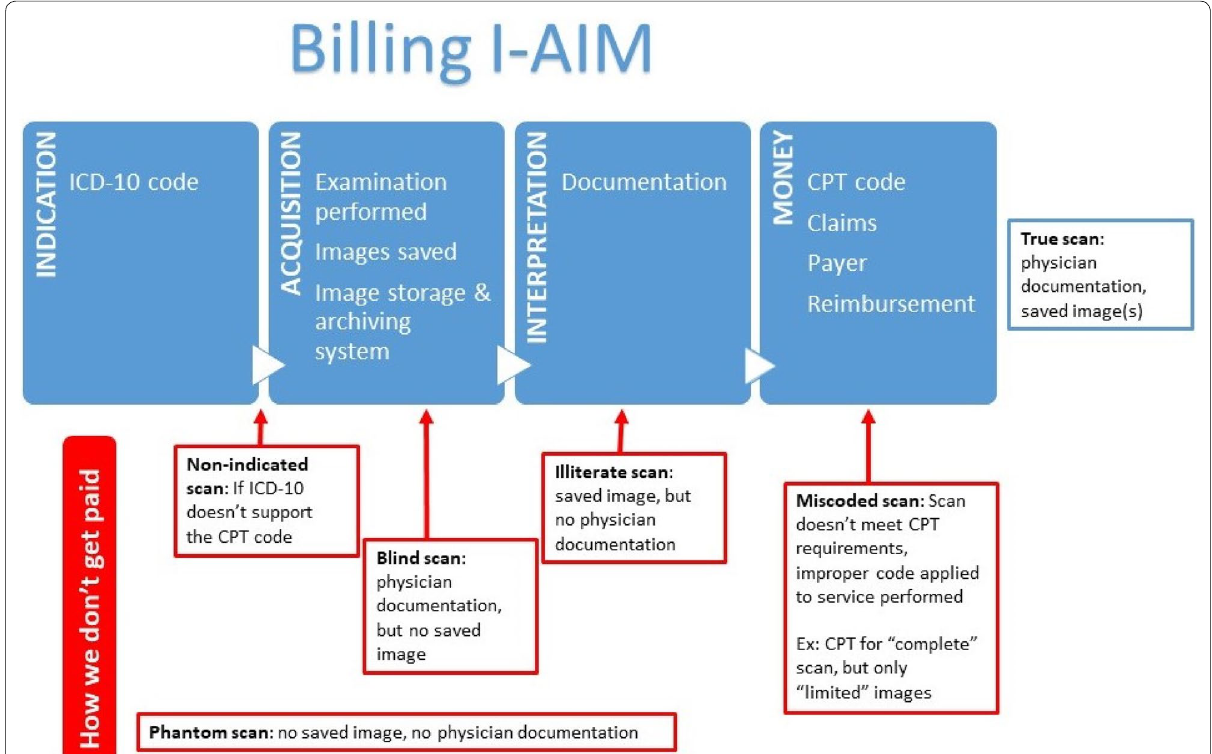
Fig. 1 Billing I-AIM is a simplified framework to enhance provider-based reimbursement and identify common